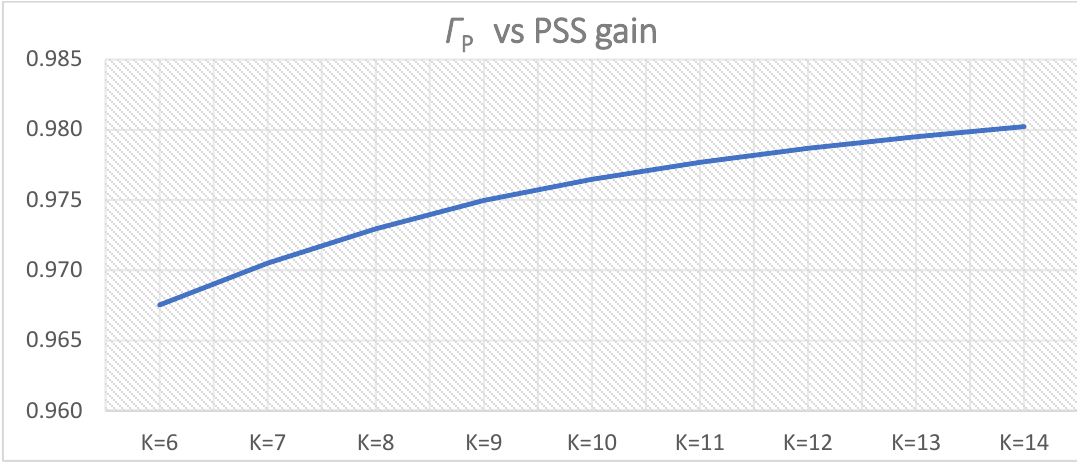
Figure 22. Γ P ( Γ Pi,l 1 and Γ Pi,u 1 from Table 7 and Table 8) for PSS parameters T = 0.5 s, K = 6 – 14.